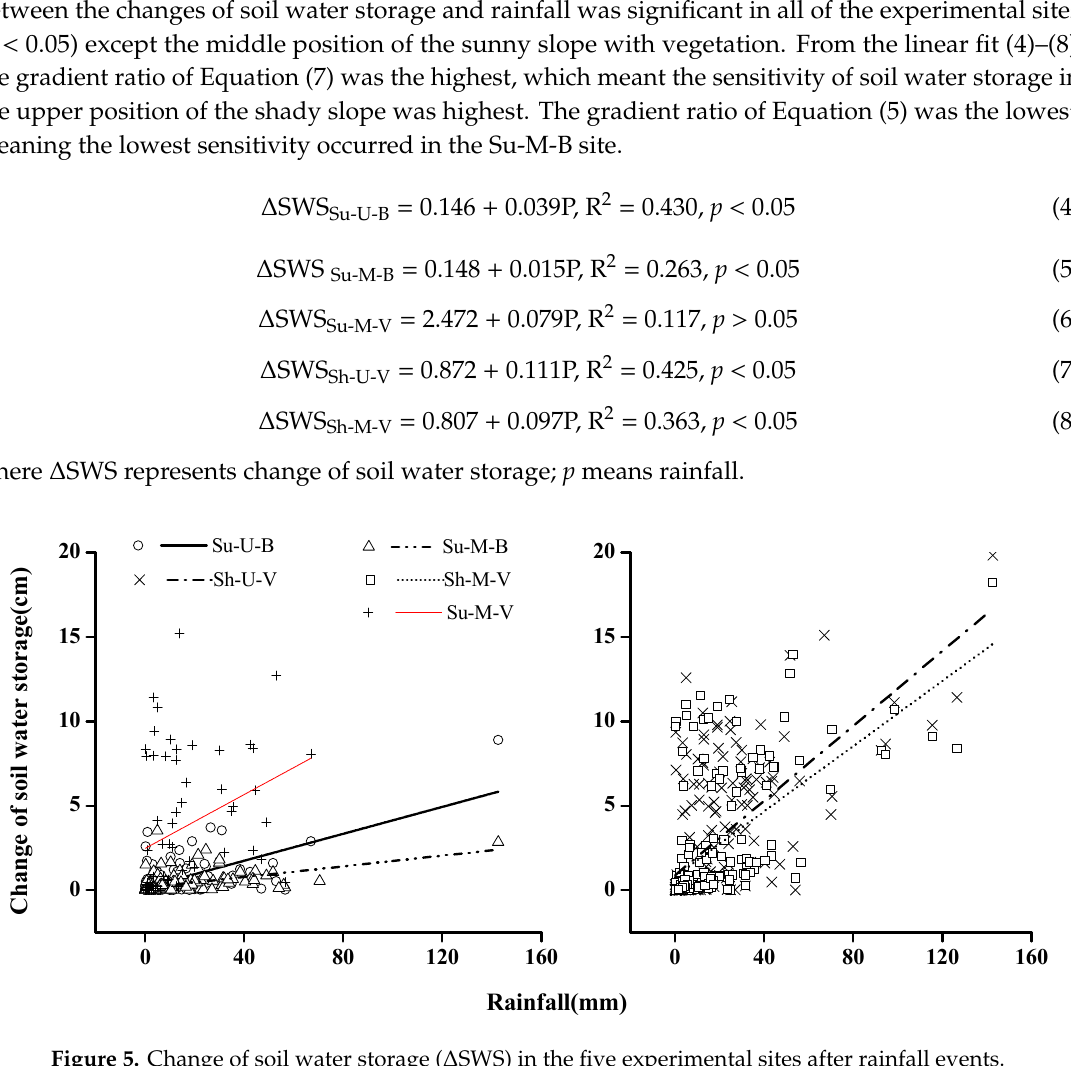
Figure 4. Frequency distribution of soil water storage in the five experimental sites. Table 4. Statistic values of slope soil water storage in the collapsing gully slope.